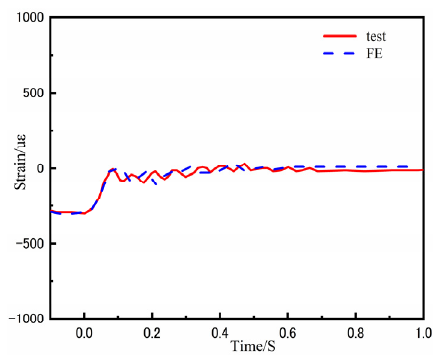
Figure 9. UC1 strain time history.